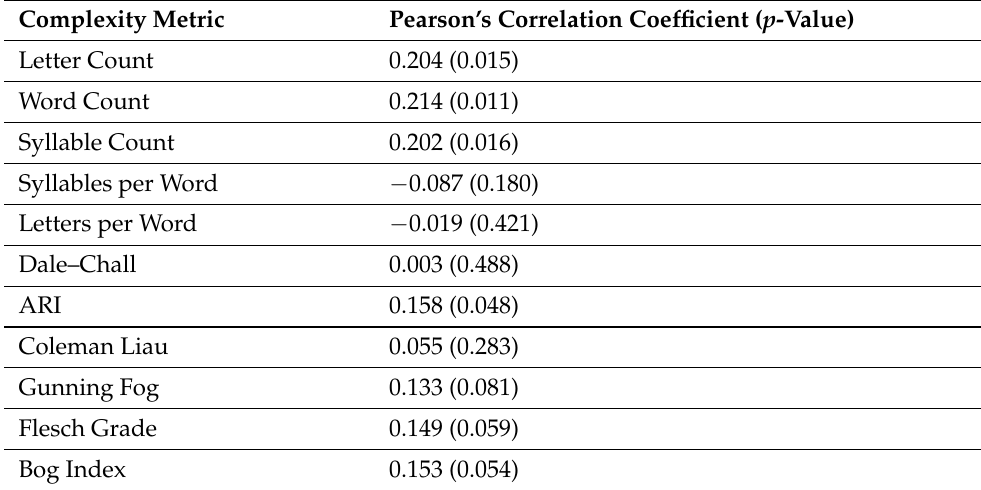
Table 2. Pearson’s correlation coefficients for readability metrics and response times.